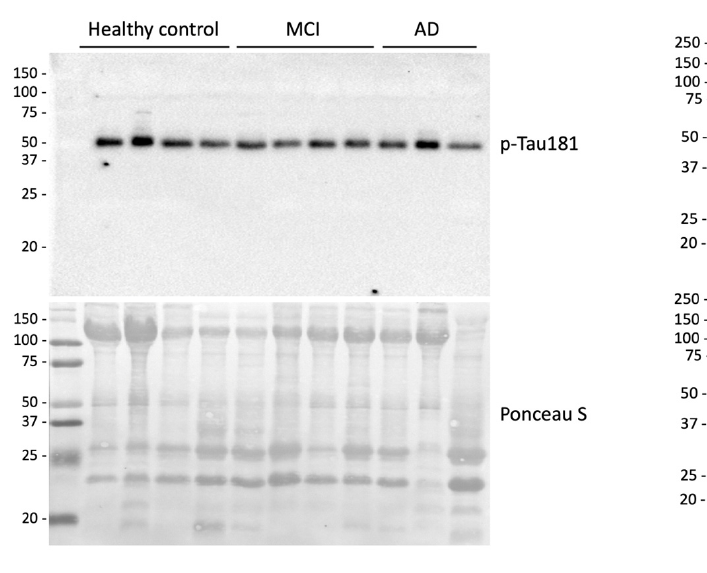
Figure 4. Strip plot showing the concentration of APP-CFT in the control group, in prodromal AD (MCI), and in mild-to-moderate AD. Boxes specify medians and quartiles, vertical spikes represent the largest or smallest value within the IQR of the upper or lower quartile. Three asterisks indicate p ≤ 0.001. MCI: mild cognitive impairment due to Alzheimer’s disease, AD: Alzheimer’s disease. Representative Western blot of p-tau and APP-CTF are shown in Figure 5a,b, respec- tively.